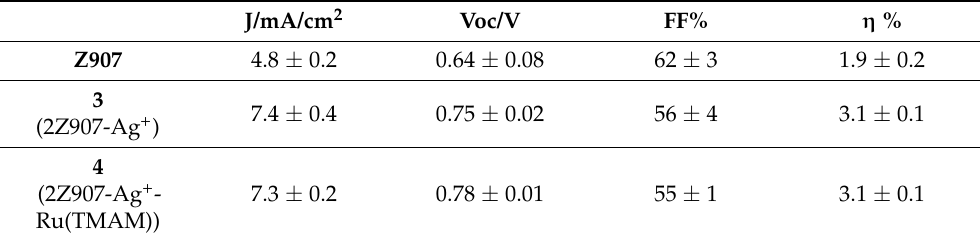
Table 2. Photovoltaic parameters of Z907 , 3 (2Z907-Ag + ), and 4 (2Z907-Ag + -Ru(TMAM)) sensitized cells recorded in the presence of Co(bpy) 2+/3+ redox mediator. The efficiency parameters were obtained by averaging the performance of a set of 5 cells.